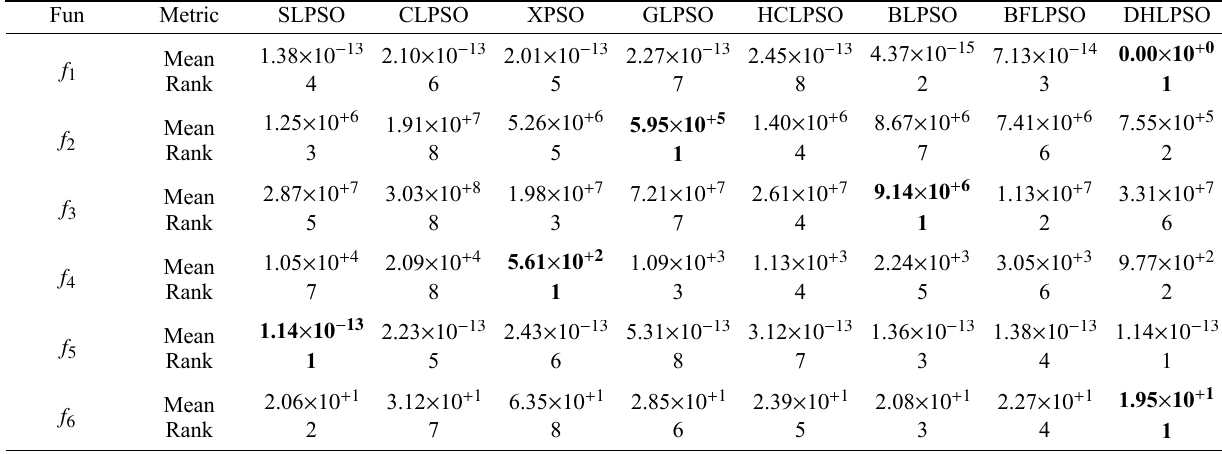
Table A3 Comparison results ( D =